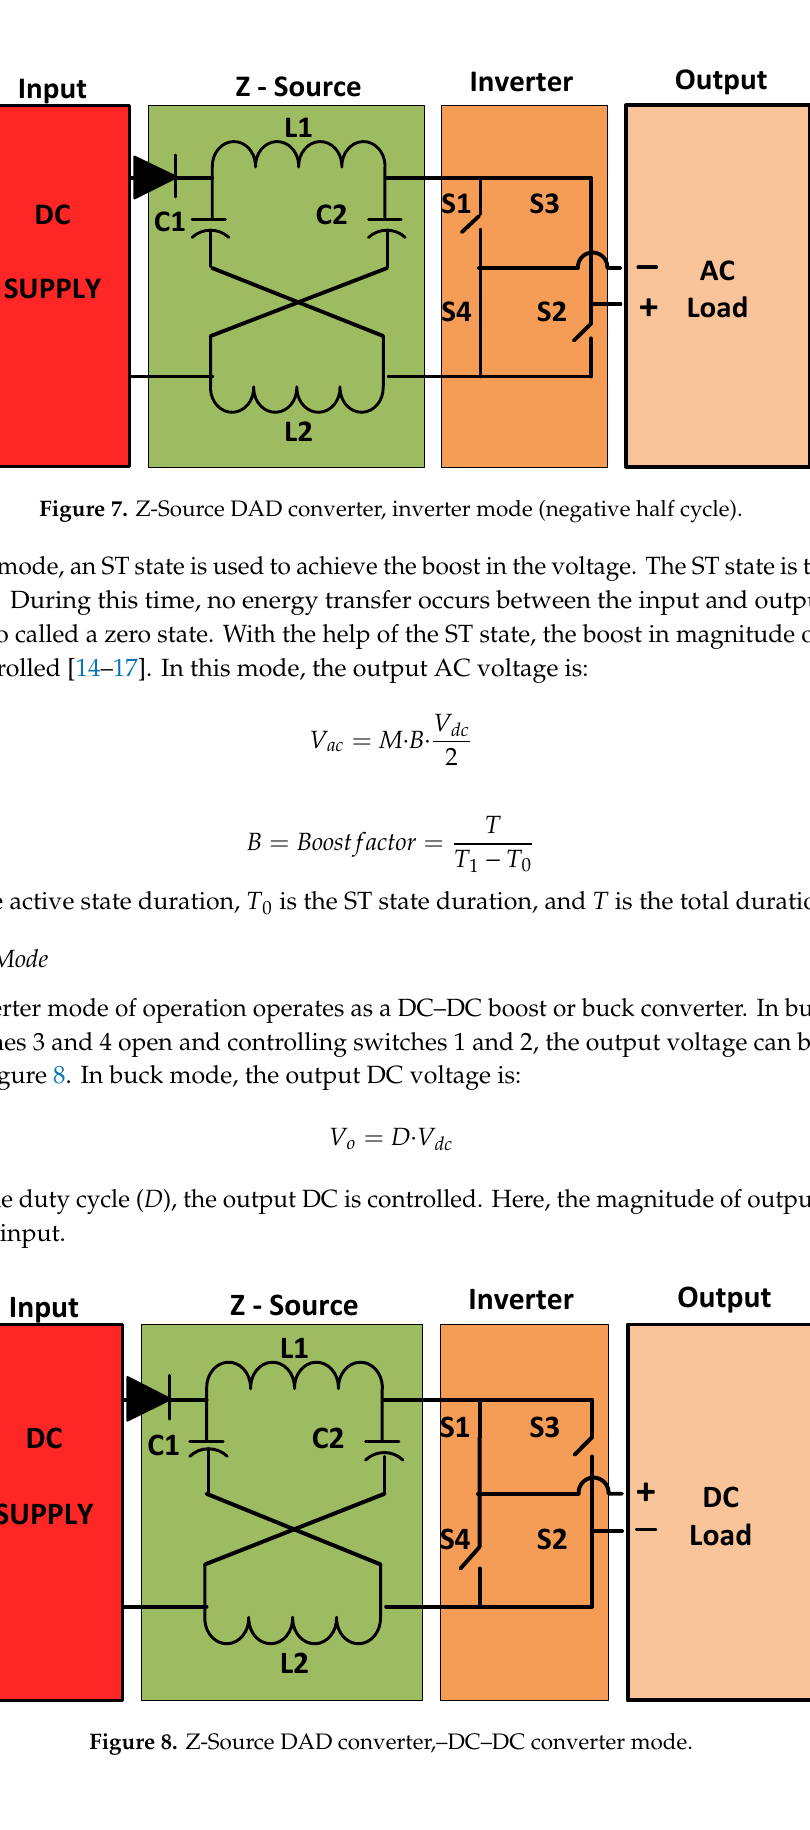
Figure 6. Z-Source DAD converter,inverter mode (positive half cycle).